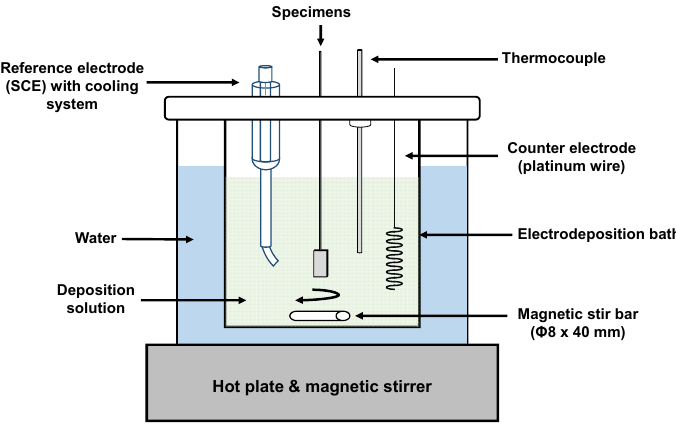
Figure 1. Schematic of electrodeposition apparatus. SCE: saturated calomel electrode.